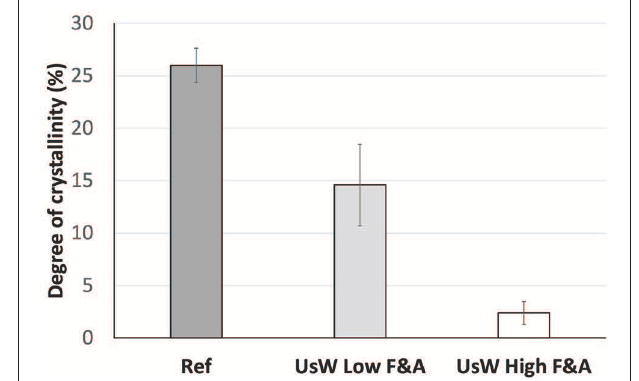
FIGURE 4 | Degree of crystallinity at the weld line in CF/PPS single-coupons welded in low force and low amplitude conditions (300N, 52 µ m) and in high force and high amplitude conditions (1,000N, 86 µ m peak-to-peak) as compared to reference values (press consolidated neat PPS) (Koutras et al., 2018